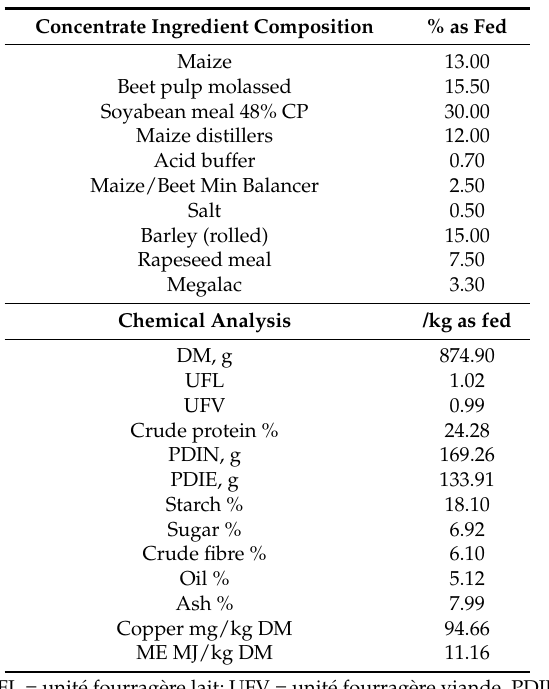
Table 4. Ingredient formulation and chemical composition of TMR